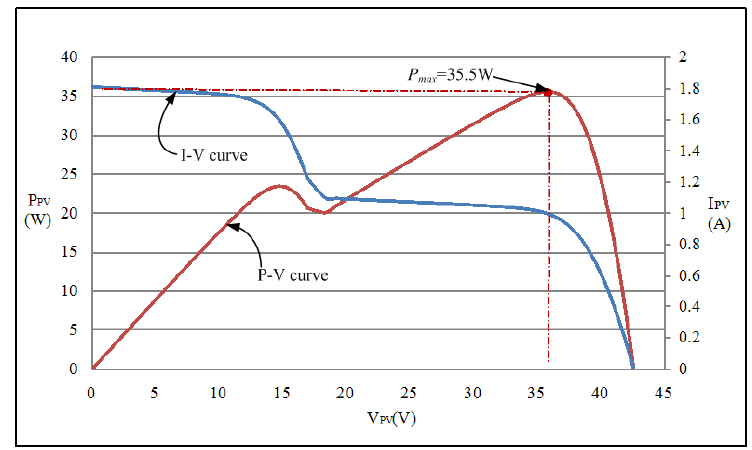
Figure 8. I–V and P–V characteristic curves of the two-serial and one-parallel module array with 0% and 40% shading.